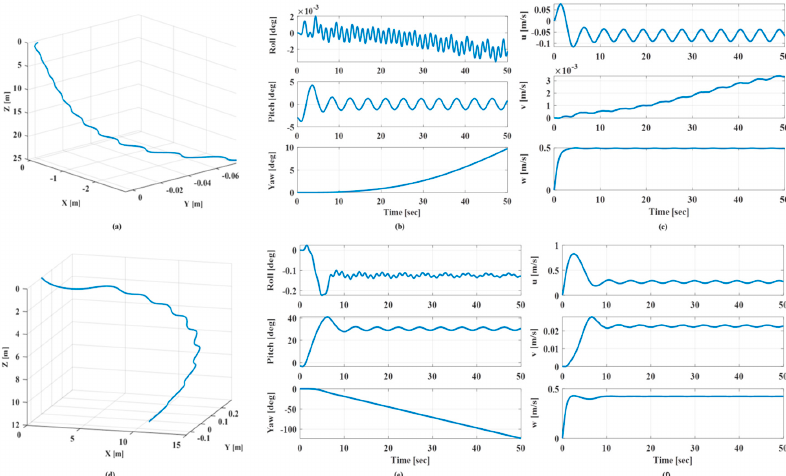
Figure 15. Simulation results of dynamic behavior of an UUV without disturbance: ( a ) X - Y and Z - X trajectory of the UUV without thrust input; ( b ) Euler’s Angles of the UUV; ( c ) Linear velocity of the UUV; ( d ) X - Y and Z - X Trajectory of the UUV with thrust input(port and starboard: 8.0 kgf); ( e ) Euler’s angles of the UUV; ( f ) Linear velocity of the UUV.